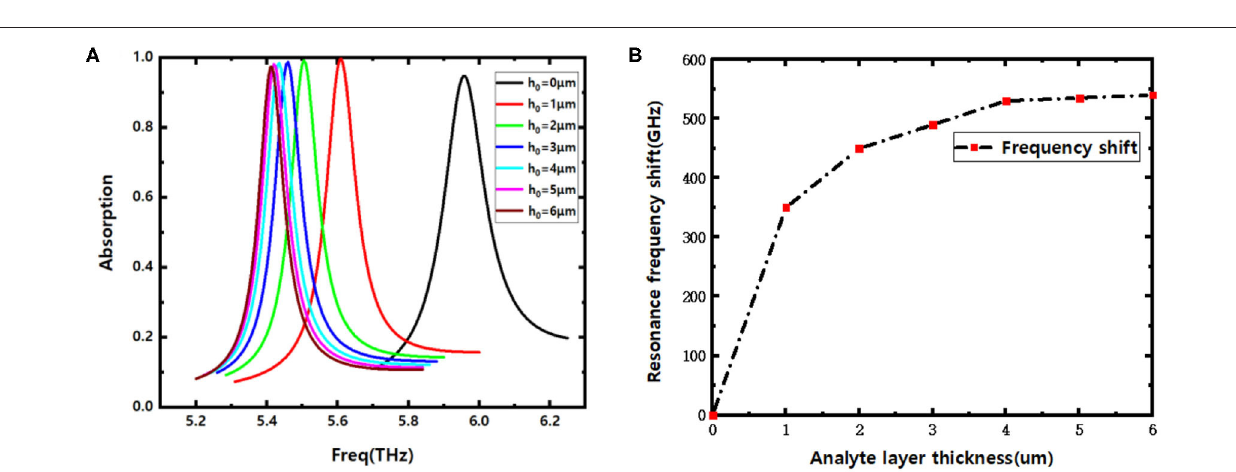
1 f/ 1 h the thickness sensing is defined as S 0 [24], in which = 1 f is the resonance frequency offset and 1 h 0 is the thickness variation of analyte slice. When the thickness of the